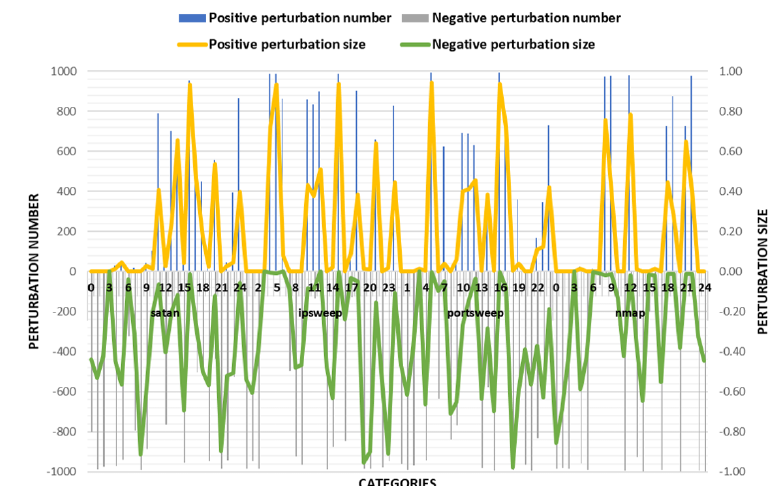
Figure 3. Comparison of the number of perturbation features and the size of the disturbance in